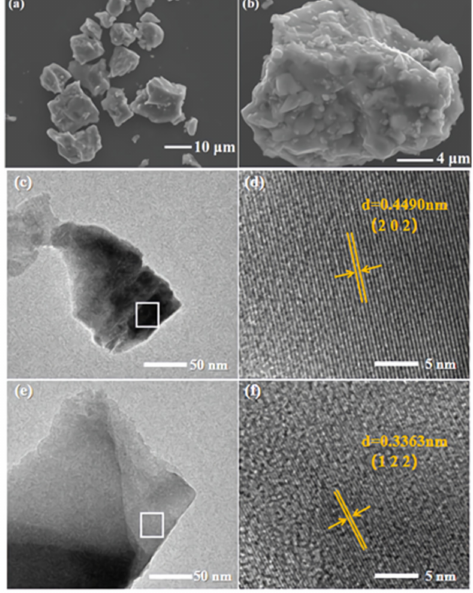
Figure 2. ( a , b ) SEM images of Ca 1.8 Li 0.6 La 0.6 (PO 4 ) 2 phosphor, ( c – f ) TEM and HRTEM image of